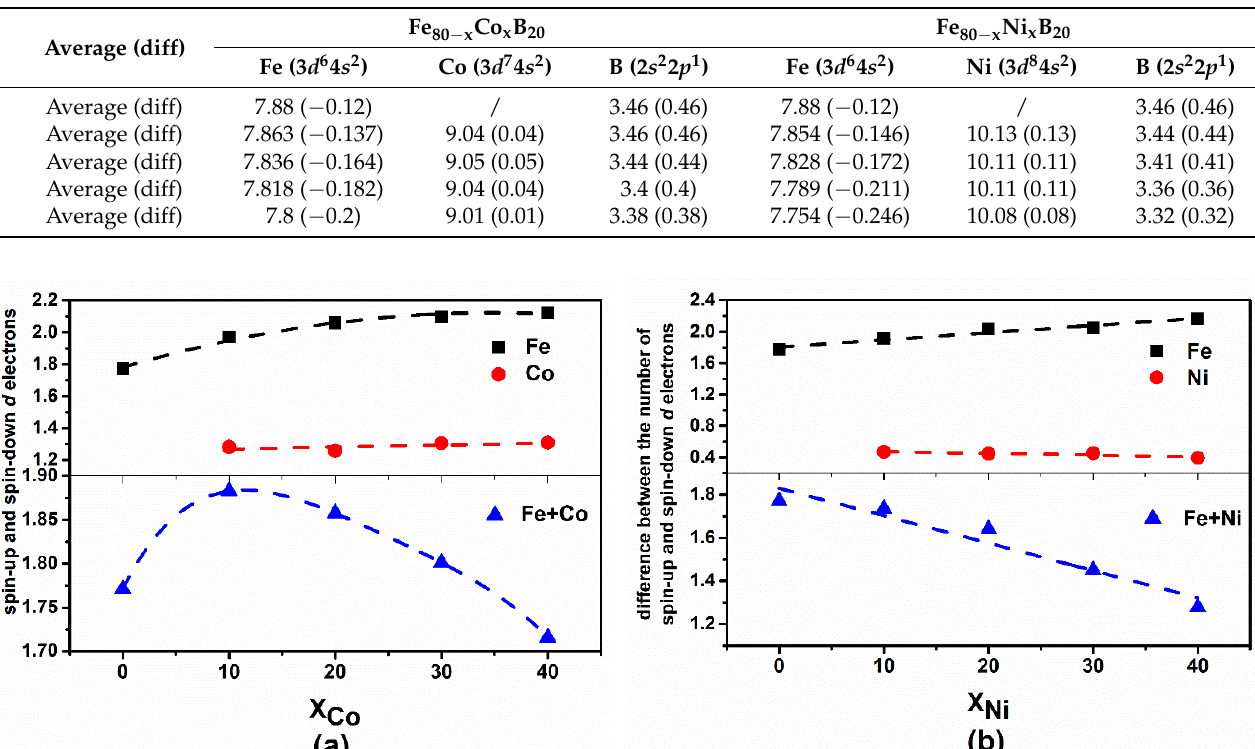
Table 1. Valence electron distribution of each element for different contents of Fe 80 − x Co x B 20 and Fe 80 − x Ni x B 20 (x = 0, 10, 20, 30, and 40 at.%) amorphous alloys.